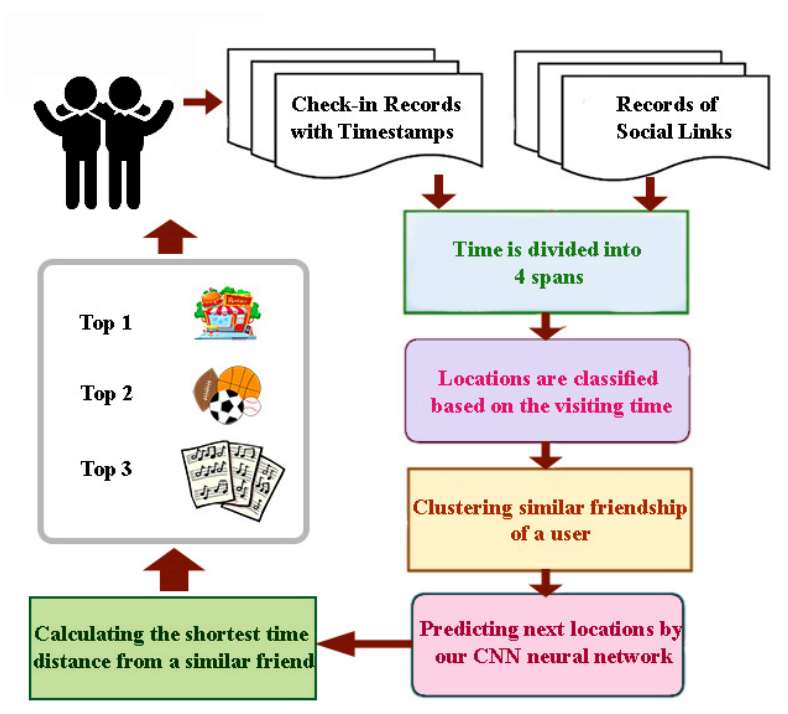
Figure 4. RecPOID framework for recommending points-of-interest (POIs) according to the importance of friendship.